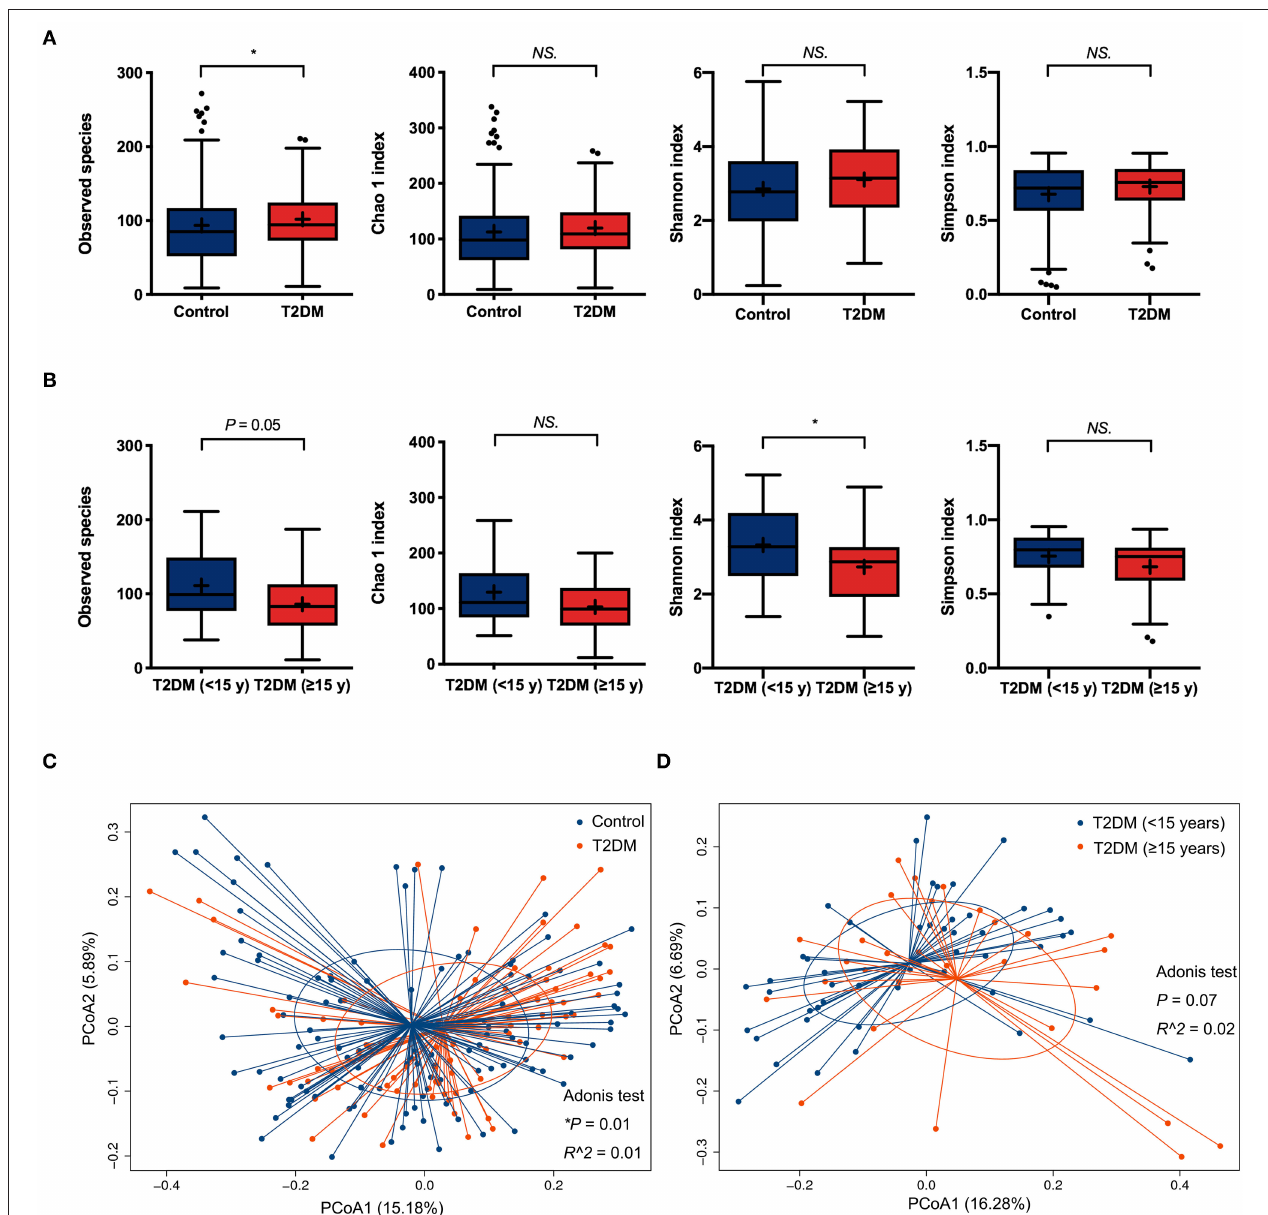
FIGURE 1 | The α -diversity and β -diversity analysis of the conjunctival microbiota. (A) Comparisons of α -diversity indices between the controls and T2DM patients (113 vs. 79 samples). (B) Subgroups comparisons of α -diversity indices between patients with less and more than 15 years’ duration of T2DM (50 vs. 29 samples). Wilcoxon signed-rank test was used to compare the difference. (C) Comparison of β -diversities between the controls and T2DM patients (113 vs. 79 samples). (D) Comparison of β -diversities between patients with less and more than 15 years’ duration of T2DM (50 vs. 29 samples). Wilcoxon signed-rank test was used to compare the α -diversity difference, and Adonis test was used to compare the β -diversity difference between two groups. NS. means no significance; * P <